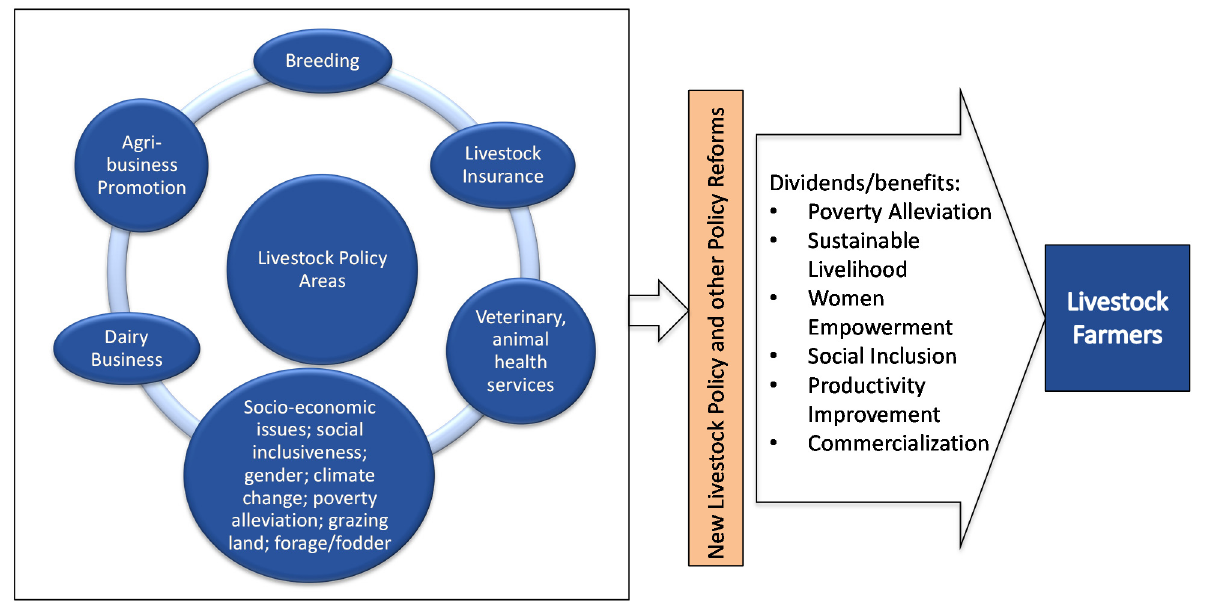
Figure 1. Model of study: interrelationships of livestock policy areas and expected outcomes (dividends) of the new livestock policy to livestock farmers and